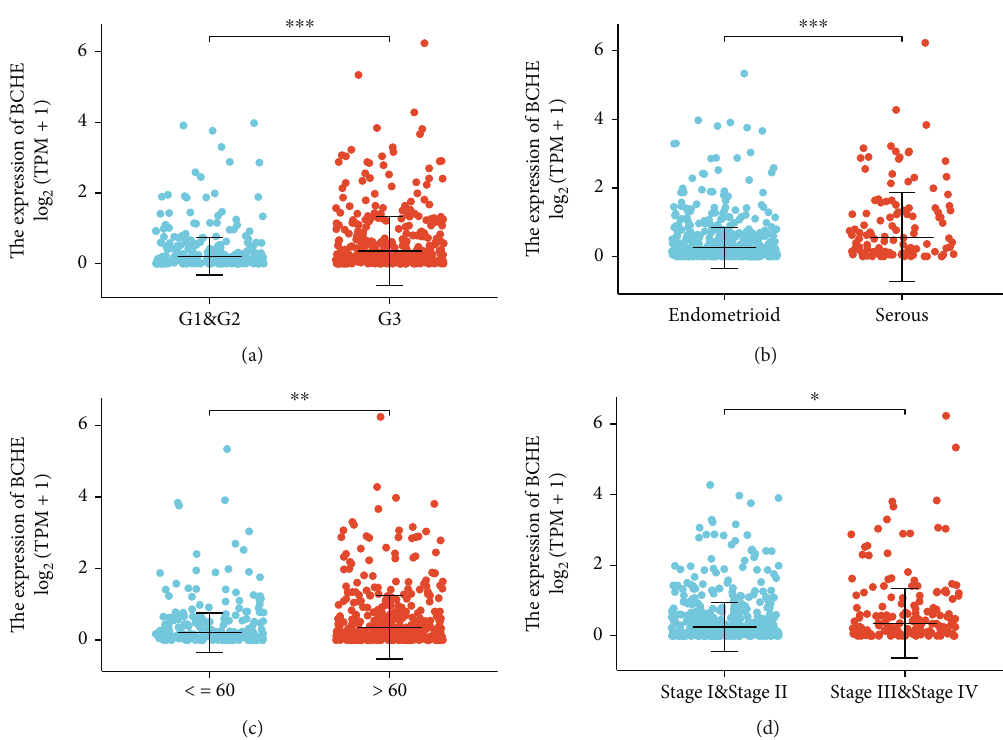
Figure 2: Di ff erential BCHE expression in various clinicopathological parameters. Expression of BCHE was signi fi cantly di ff erent in (a) histological grade, (b) histological type, (c) age, and (d) clinical stage ( ∗∗∗ p < 0 : 001 ; ∗∗ p < 0 : 01 ; ∗ p < 0 : 05